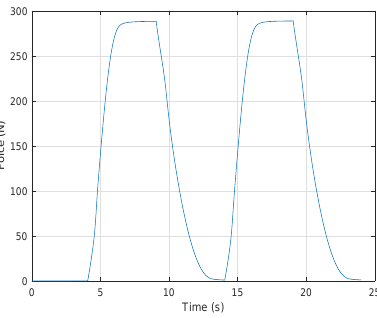
Figure 17: 3-axis CNC, test 1.3: force versus deflec- tion. Test position 1 in Fig. 5. All load cy- cles (L), single load cycle with least square fit (R).